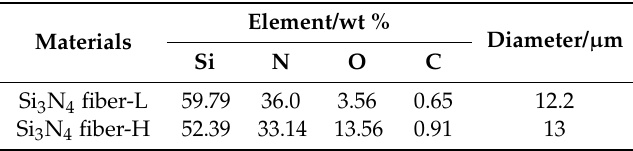
Table 1. Fundamental characteristics of the silicon nitride (Si 3 N 4 ) fibers.